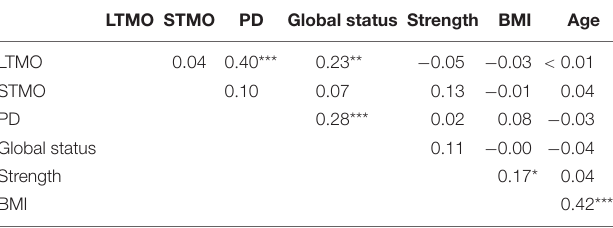
TABLE 2 | Pearson’s correlation coefficients between variables ( N =